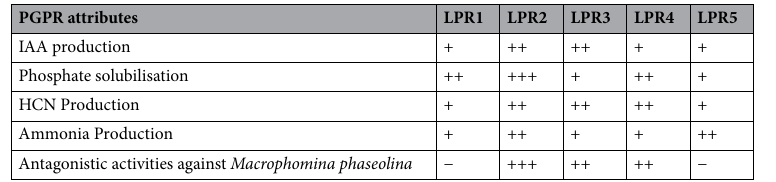
Table 1. Plant growth promoting attributes and antagonistic activities of Bacillus cereus LPR2 and other isolates. Abbreviation (+) positive; +, ++,+++ production and solubilization in increasing order; Antagonistic activities -, do not inhibit pathogen, +, ++, +++ inhibit the growth of pathogen (in increasing